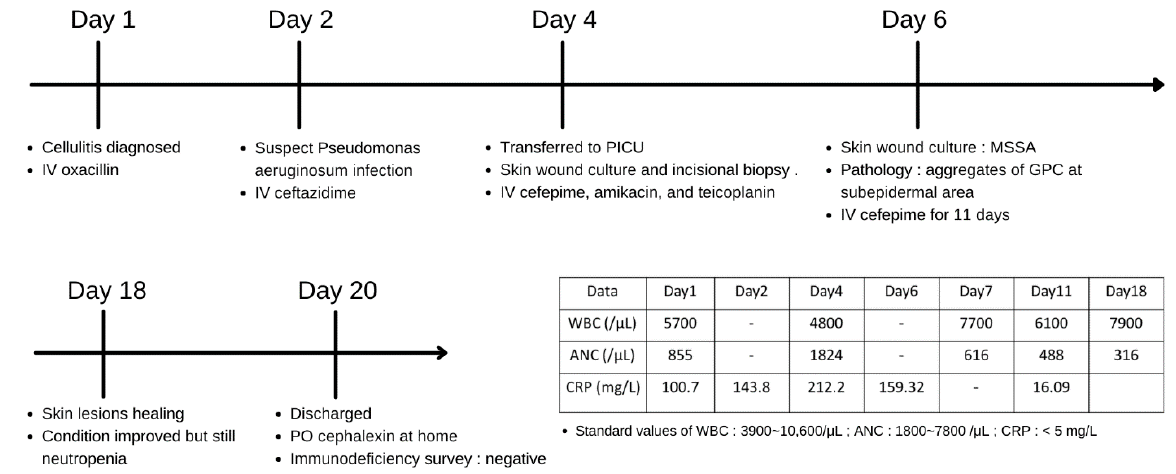
Figure 2. The pathologic images (Gram stain, ×200) of the incisional biopsy of the papulonodular skin lesion reveal ( a ) aggregates of Gram-positive cocci (white arrow) at subepidermal area and ( b ) necrotic vasculitis (black arrow) without perivascular bacterial invasion (Hematoxylin and Eosin stain, ×200).